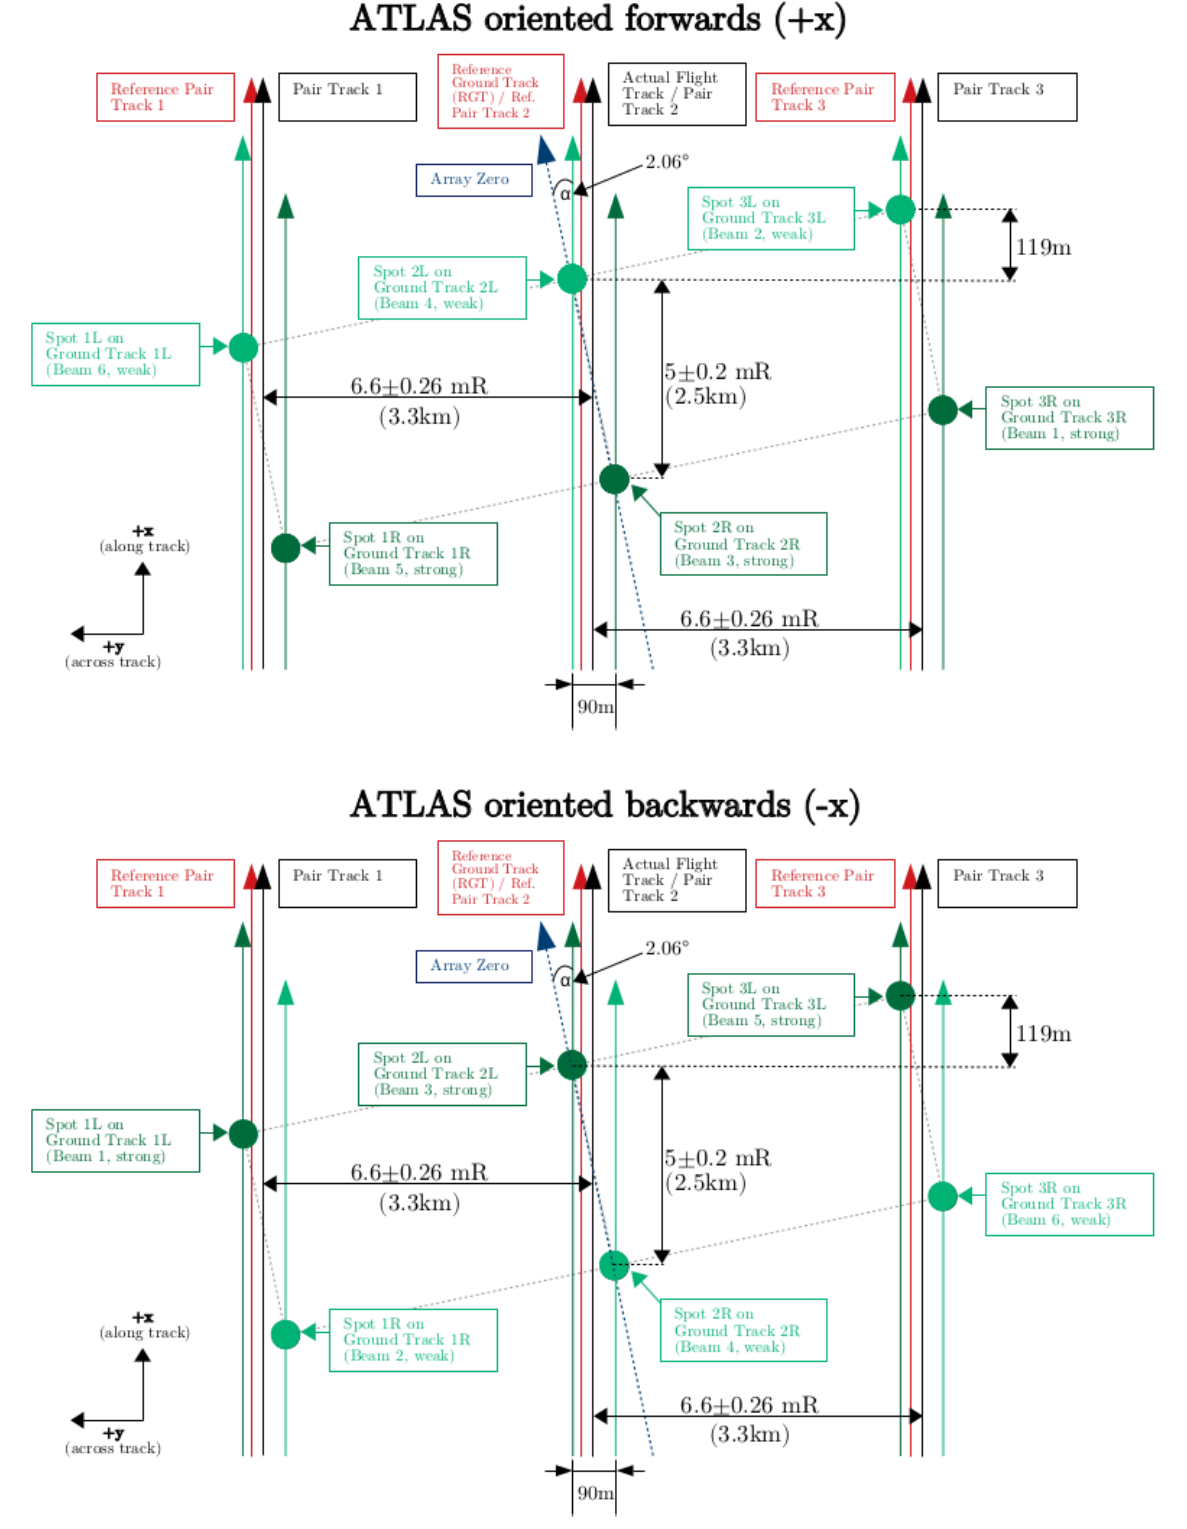
Figure 2. ICESat-2 beam pattern and track geometry. For observatory orientations of ATLAS flying forward (“weak beams leading”) and ATLAS flying backward (“strong beams leading”). Beam numbering is a feature of the transmitter array, while spot and ground track numbering is a feature of the ATLAS data products, see Table 1. (Figure from [3], Figure